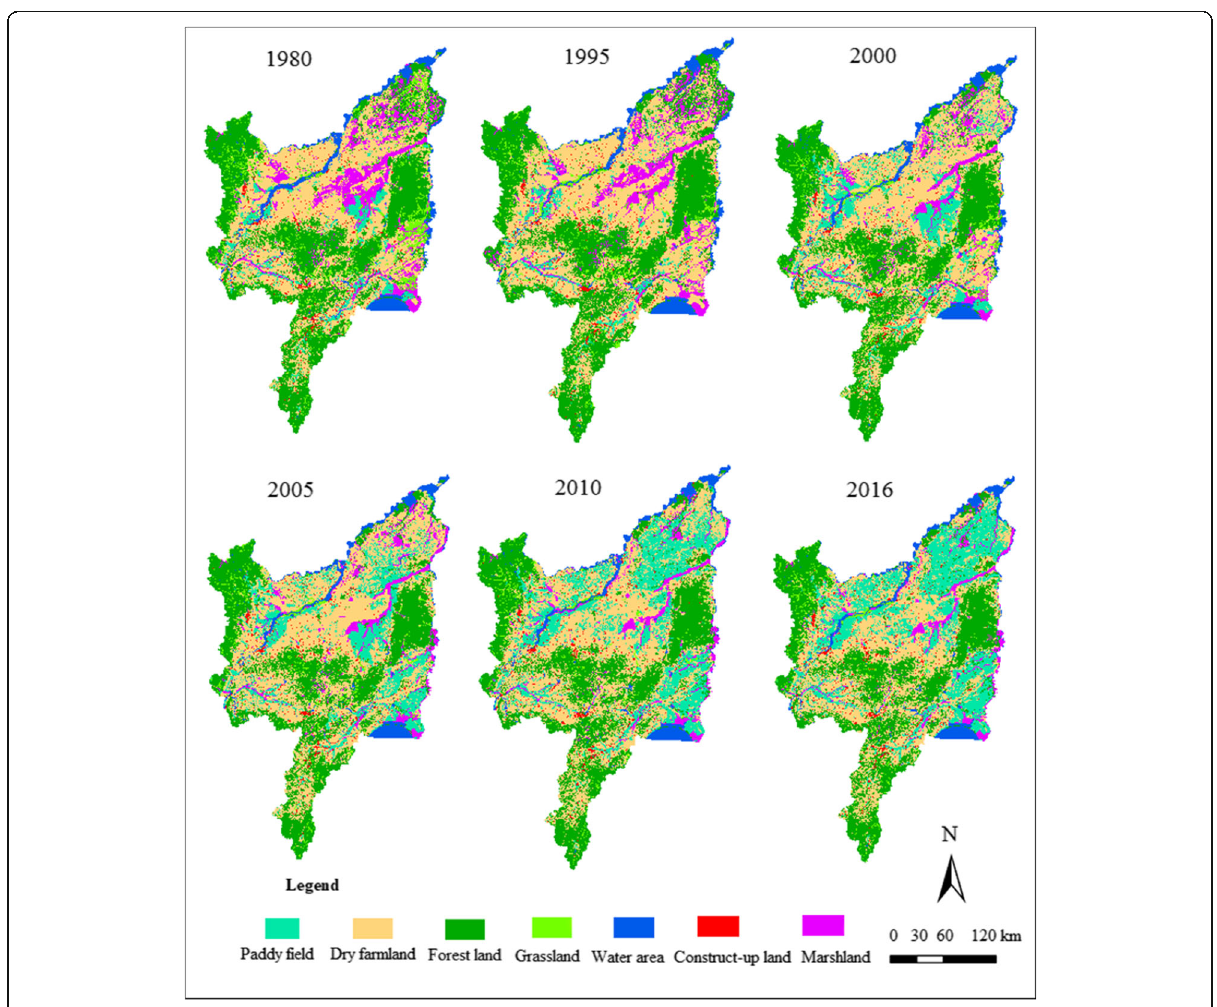
Fig. 2 Land cover maps of the study area from 1980 to